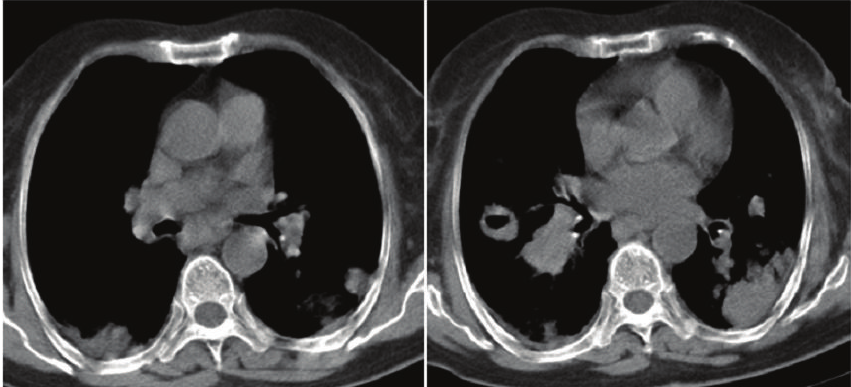
bronchoalveolar lavage was researched; cultures and poly- merase chain reaction (PCR) were done in terms of tubercu- losis, candida, and other infections. Cytology, transbronchial biopsy from the cavitary lesion in the superior segment of the lower lobe of the right lung, and mucosal biopsies were obtained, and a pathological examination was sent. The results of the cultures, ARB, and PCR were negative. After infectious causes were ruled out, PET/CT was obtained. On